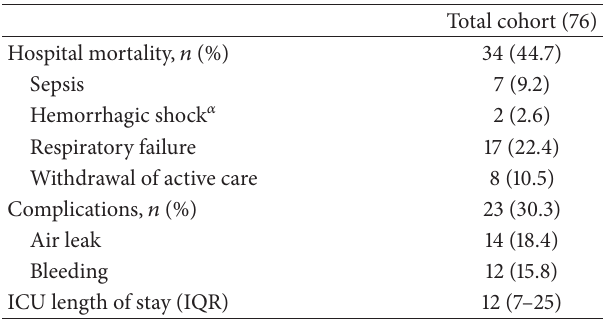
Table 3: Clinical outcomes of patients who underwent an open lung